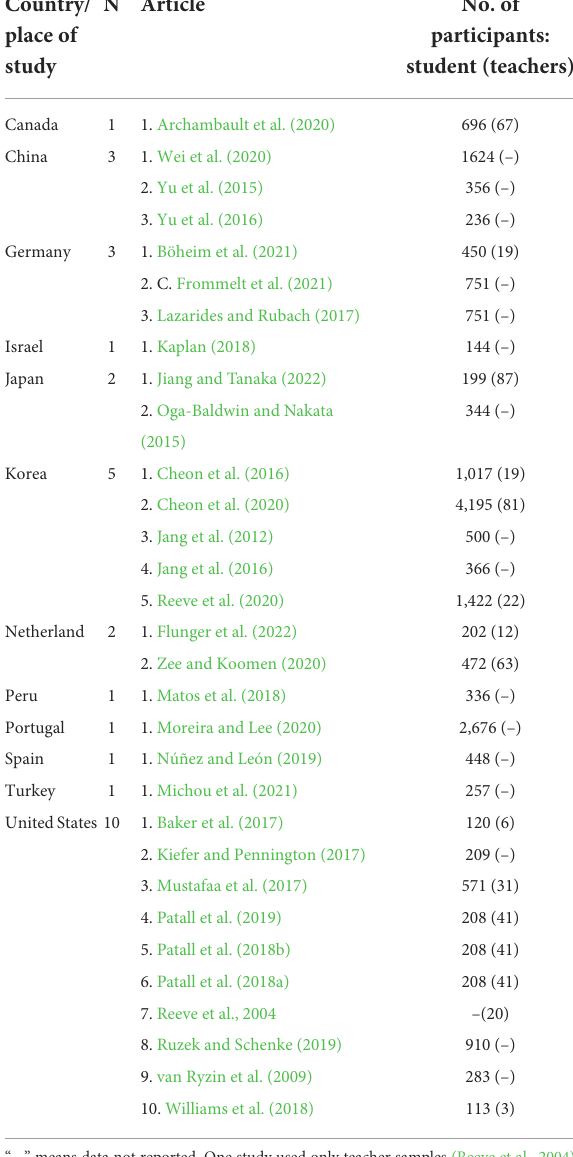
TABLE 3 A summary of countries and participants of identified studies ( N =